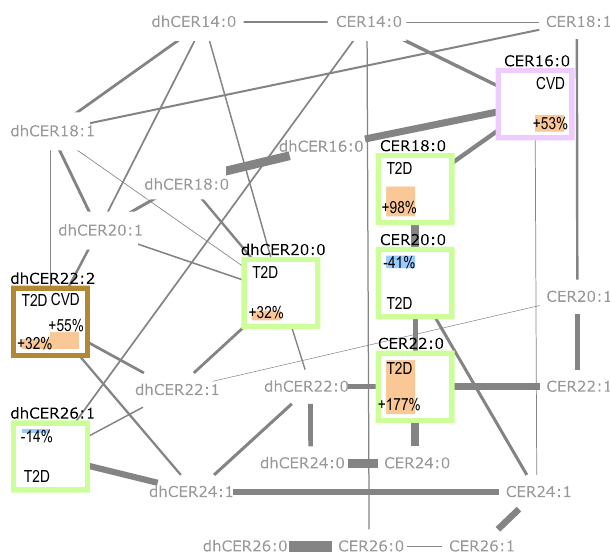
Fig. 2 Data-driven conditional independence network of (dh)ceramides. Bars within nodes show network-adjusted cardiometabolic disease risk. Left: T2D risk; Right: CVD risk; Orange: increased risk; Blue: decreased risk; Numbers: percent risk change with 1 standard deviation higher (dh) ceramide concentration. Frame colors — Green: only T2D-associated; Purple: only CVD-associated; Brown: T2D- and CVD-associated. CER ceramide, dhCER